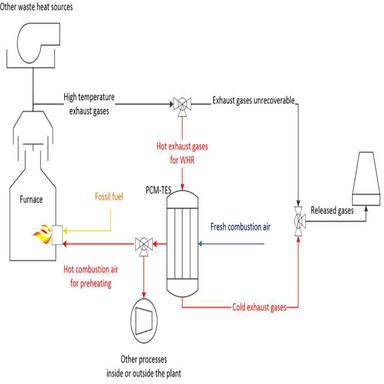
General diagram flow of the PCM-TES integration to recover heat from an exhaust gas stream exiting an industrial furnace.